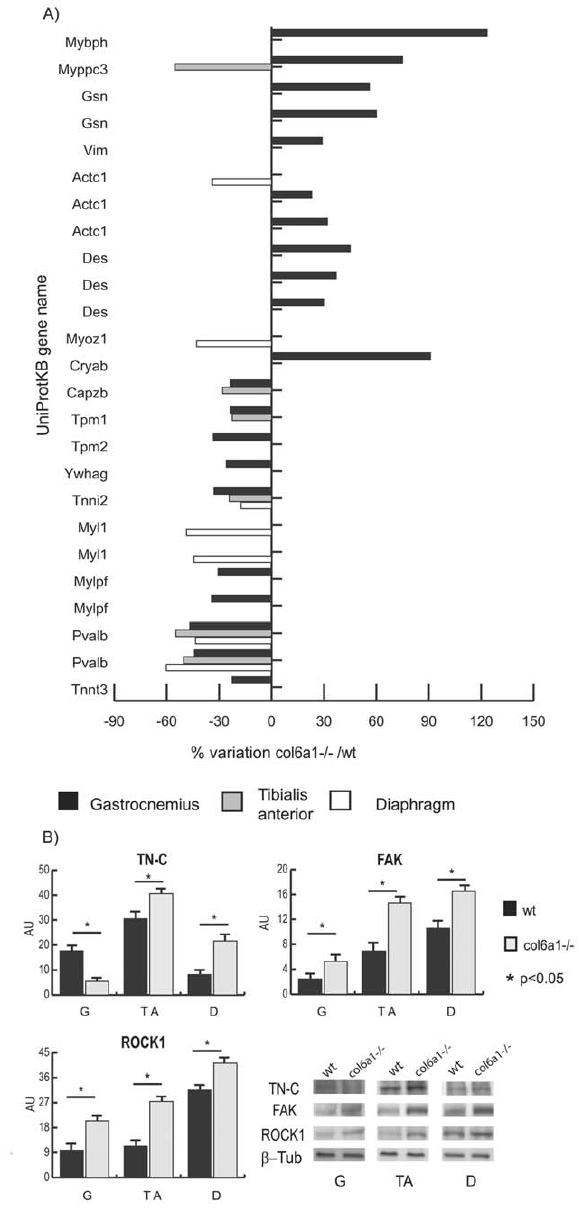
Figure 2. Histograms of proteomic results and Immunoblotting of cytoskeletal proteins. Panel A: histograms of structural and cytoskeletal proteins differentially expressed in gastrocnemius (black bars), tibialis anterior (grey bars) and diaphragm (white bars) muscles. Proteins significantly altered (Student’s t-test, p , 0.01) are expressed as % of spot volume variation in Col6a1 2 / 2 versus wild-type. (Mybph: myosin binding protein H, Mybpc3: myosin binding protein c; Gsn: gelsolin; Vim: vimentin; Actc1: actin, alpha cardiac muscle 1; Des: desmin; Myoz1: myozenin1; Cryab: alpha-crystallin B chain; Capzb: capping protein (actin filament) muscle Z-line, beta isoform; Tpm1: tropomyosin 1 alpha chain; Tpm2: tropomyosin 2 beta chain; Ywhag: 14-3-3 protein gamma; Tnni2: troponin I, fast skeletal muscle; Myl1: myosin A1 catalytic light chain; Mylpf: myosin light chain, phosphor- ylatable, fast skeletal muscle; Pvalb: parvalbumin; Tnnt3: troponin T, fast skeletal muscle). Panel B: histograms and representative immunoblot images of TN-C, FAK and ROCK1 in gastrocnemius, tibialis anterior and diaphragm of Col6a1 2 / 2 and wild-type mice (n=4; mean 6 S.D.; Student’s